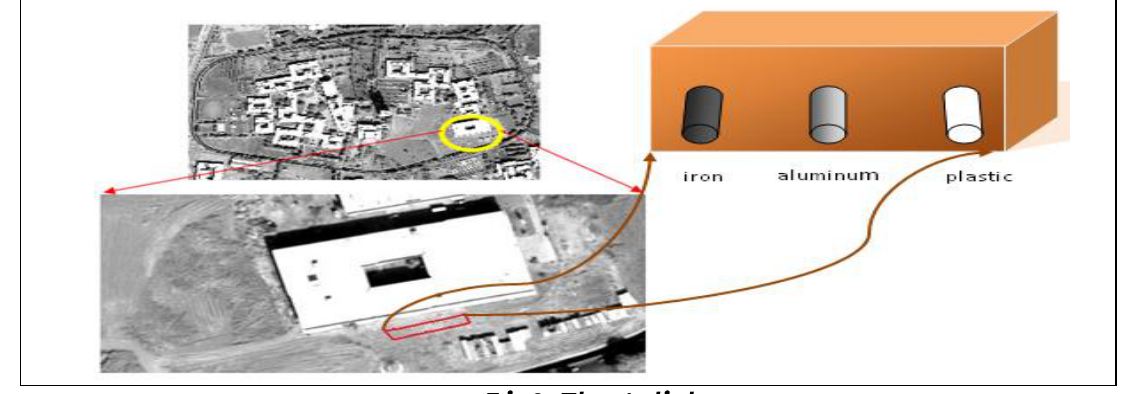
Fig.2: The studied area .